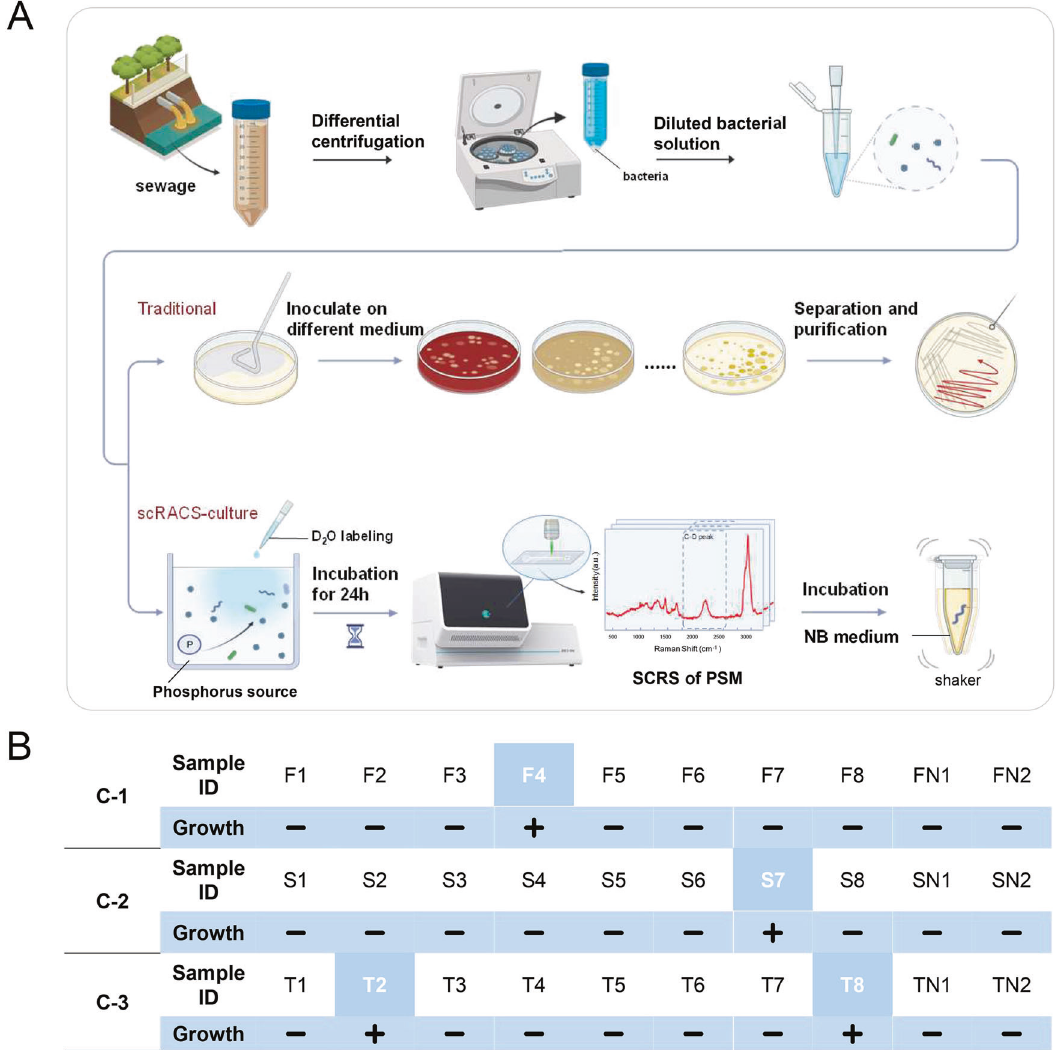
Fig. 4 One-cell RACS-Culture of metabolically active organic-PSM cells from sewage. A The work fl ow of scRACS-Culture that identi fi es and isolates inorganic PSM from the sewage samples. B Results from culturing the isolated single organic-PSM cells in each receiving tube of 20 μ L broth medium, respectively. In Tube FN1, FN2, SN1, SN2, TN1 and TN2, empty droplets (i.e., without cells) were sorted and cultured. In Tube F1- F8, S1-S8, T1-T8, the targeted organic-PSM cells were sorted and cultured in a one-cell-one-tube